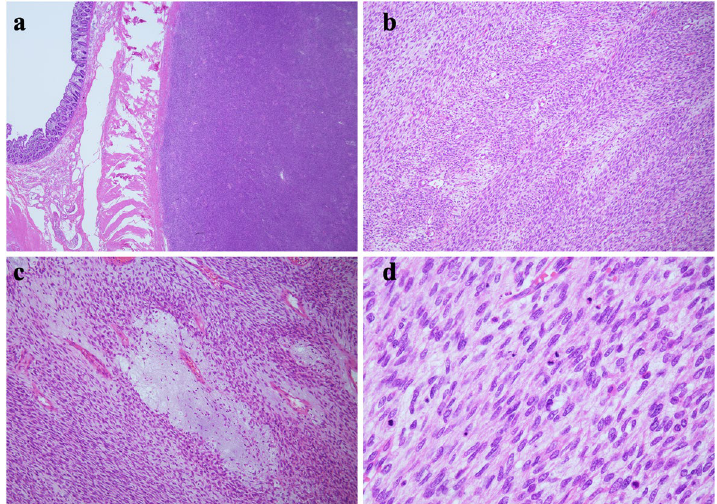
Fig. 2 a A well-defined extramural mass attached to the transverse colon. b Dense proliferating spindle-shaped cells with bundle and herringbone architecture. c Hypervascularization with scattered edematous stroma. d Spindle-shaped cells with relatively uniform nuclei and prominent